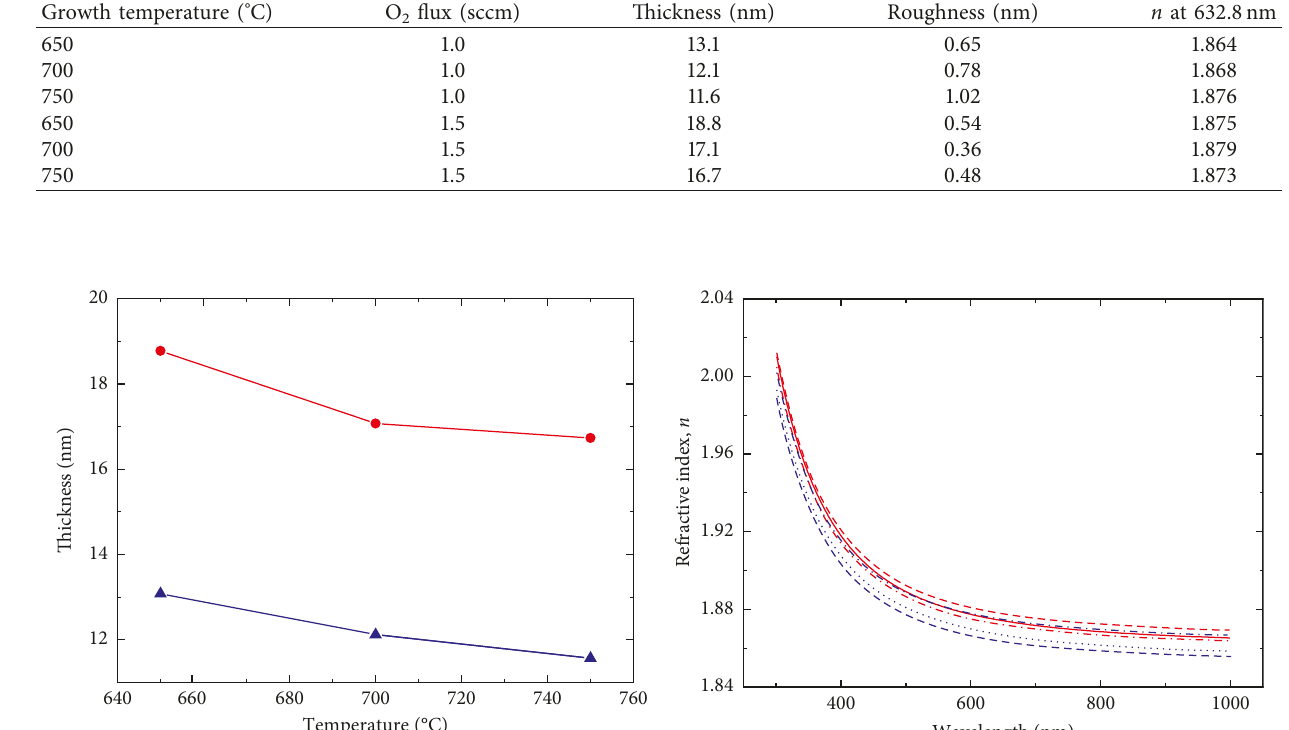
Table 1: Thickness, roughness, and refractive index at λ Growth temperature ( ° C)